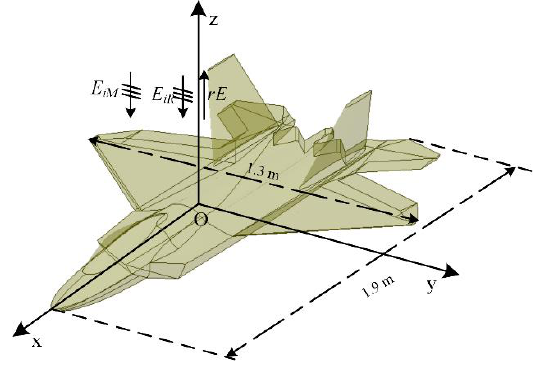
Figure 12. The sketch picture of the metal F22 structure.